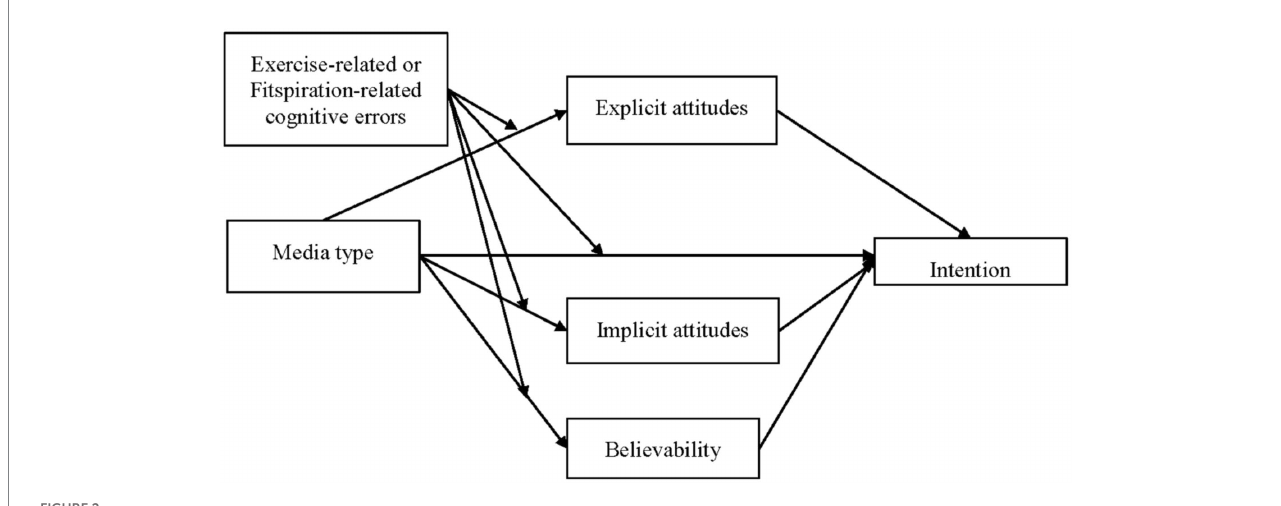
FIGURE 2 Model tested in study